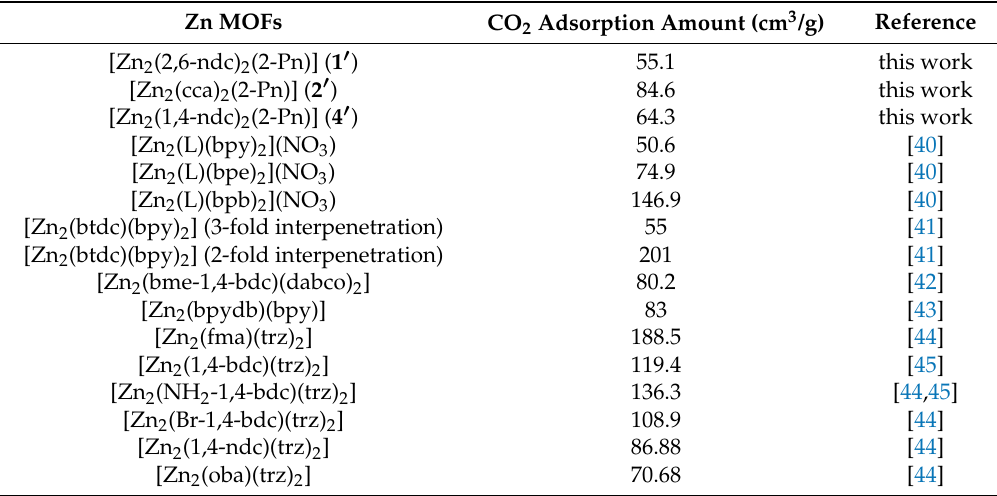
Table 2. Low-pressure CO 2 adsorption analyses for a series of Zn metal–organic frameworks (MOFs) at 195 K. Zn